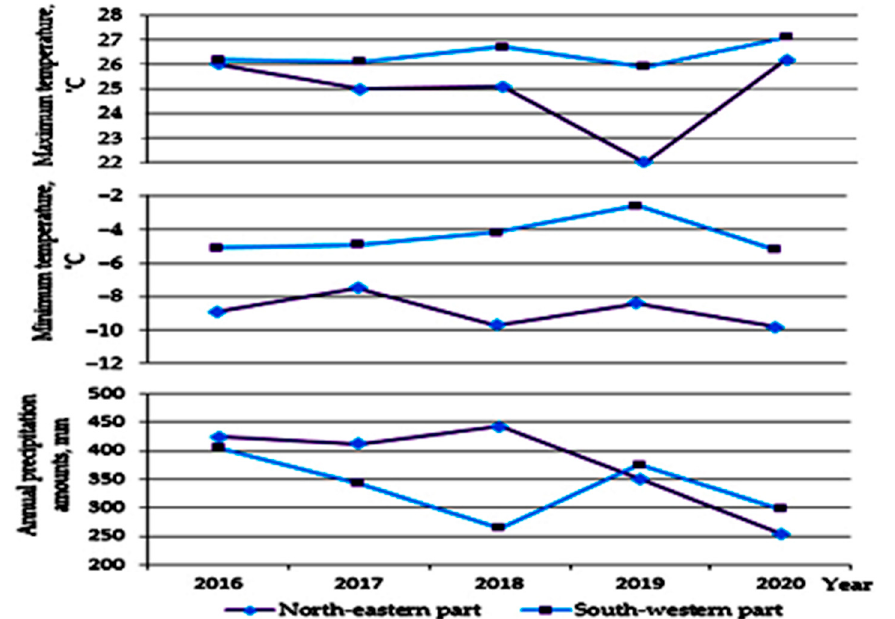
Figure 2. Climatic characteristics of the dry steppe zone of the Lower Volga region (according to weather stations in the cities of Kamyshin and Kotelnikovo). Location of the meteorological station in Kamyshin (north-eastern part): latitude 50.07, longitude 45.37. Location of the meteorological station in Kotelnikovo (south-western part): latitude 47.63, longitude 43.15. Adapted with permission from [17].